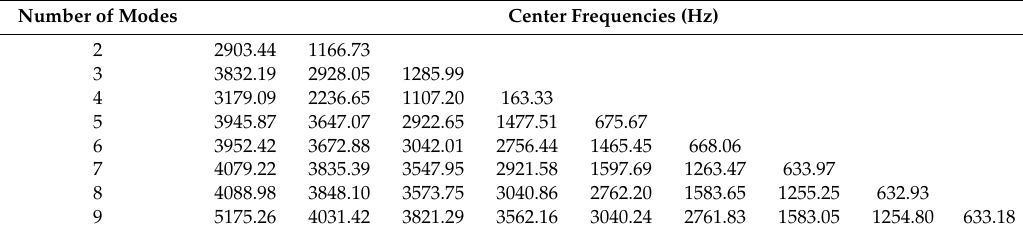
Table 2. Center frequencies with different K value.